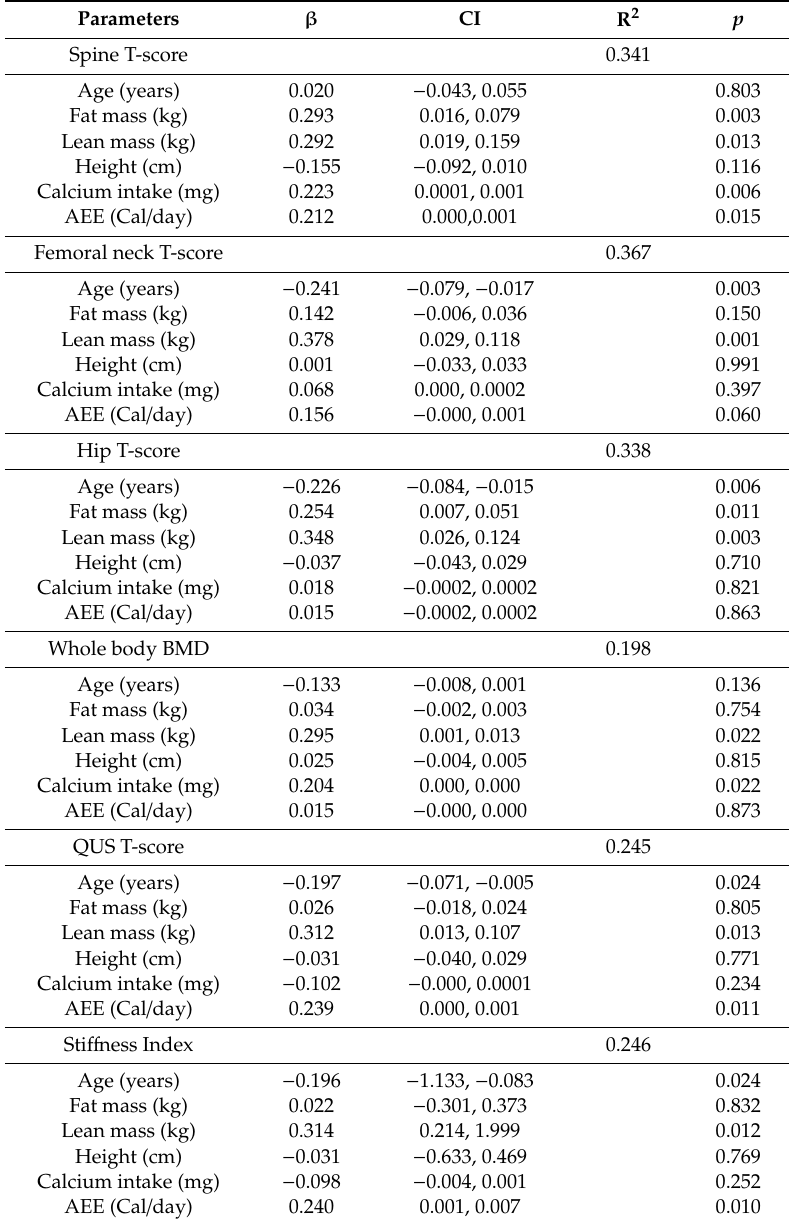
Table 4. Regression analysis of bone health, QUS parameters and body